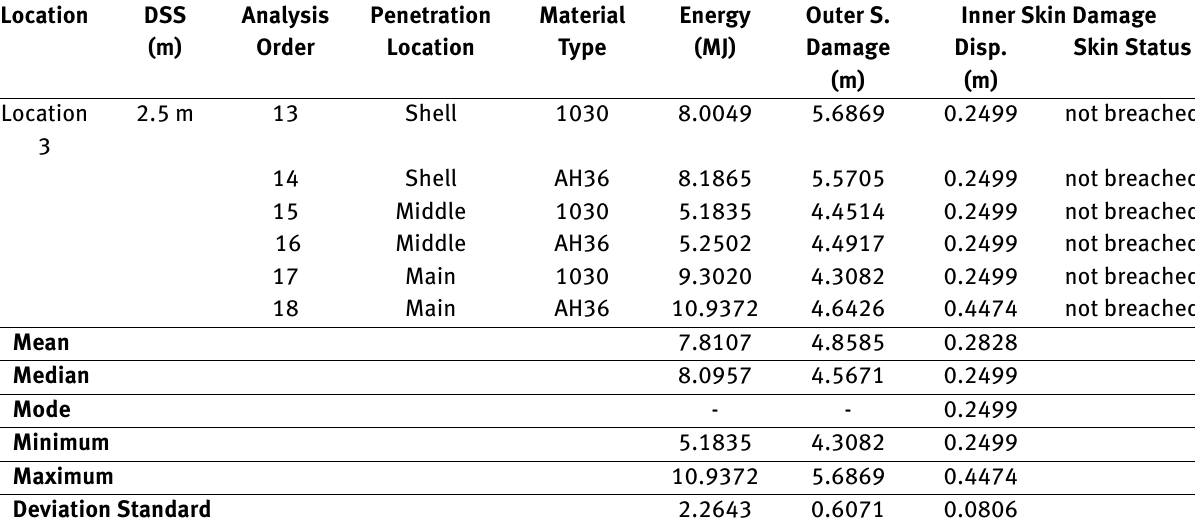
Table A.3: Statistical analysis on Location